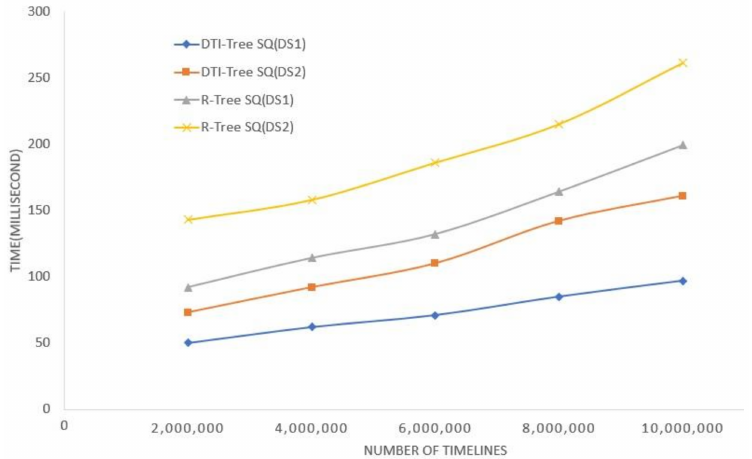
Figure 15. Similarity query